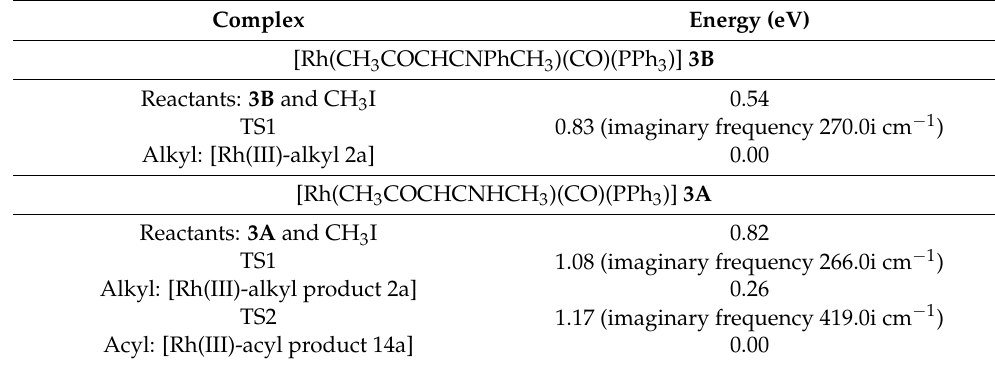
Table 6. PW91/TZP DFT-calculated energies (eV) for the reaction mechanism of the oxidative addition of CH 3 I to the applicable [Rh(N,O-BID)(CO)(PPh 3 )]